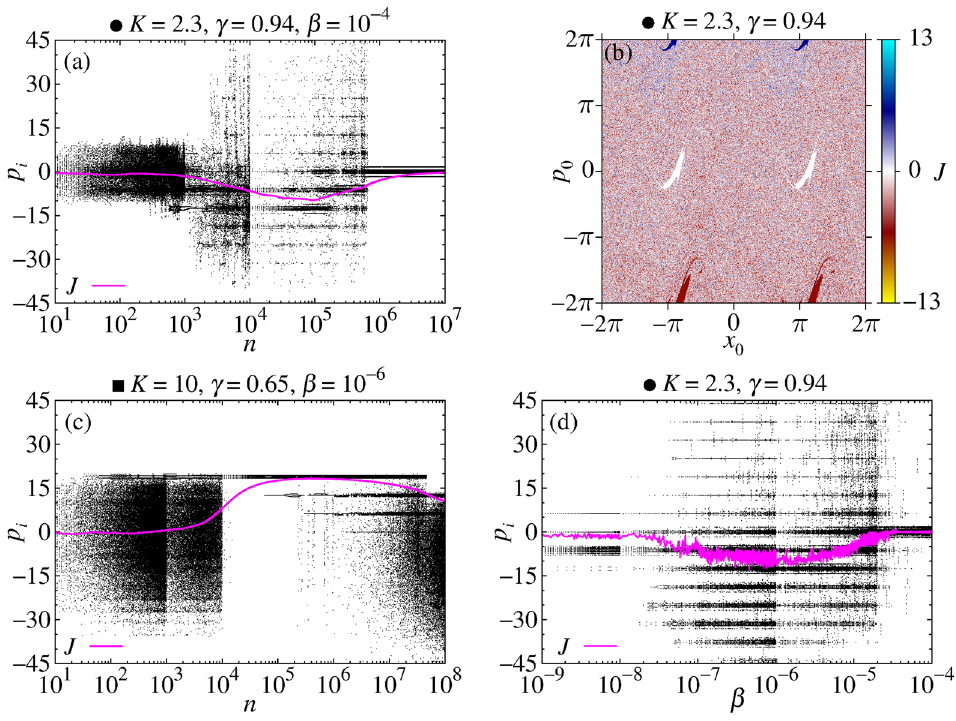
Figure 3. ( a ) and ( c ) We plot p i × n for the parametric combinations indicated by • and (cid:31) in Fig. 1, respectively. ( d ) Displays p i × β with n trans = 2 × 10 6 and n = 10 6 for the point • . The pink curves plotted in these diagrams represent the respective RC. ( b ) It is plotted the basin of attraction for only one ratchet map, for K = 2.3 , γ = 0.94 , and n = 10 5